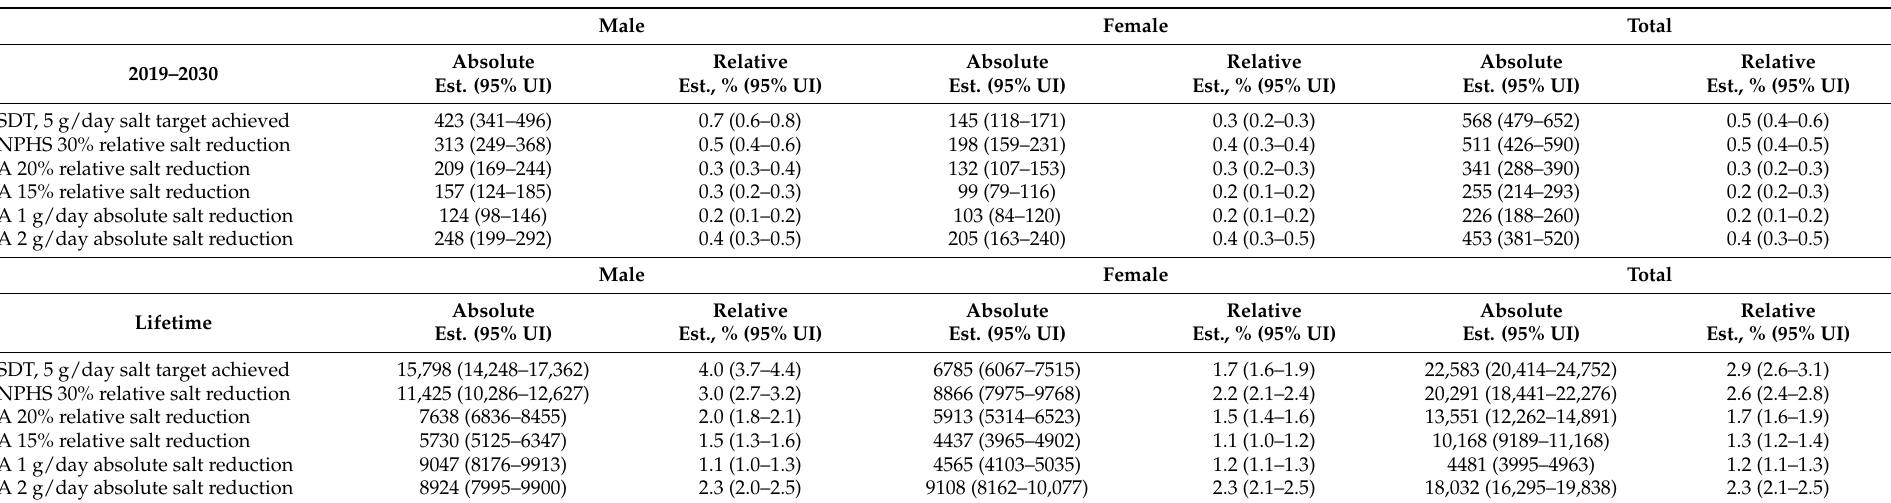
Table 3. Estimated reductions in cumulative mortality from CKD in Australia between 2019 to 2030 and over the